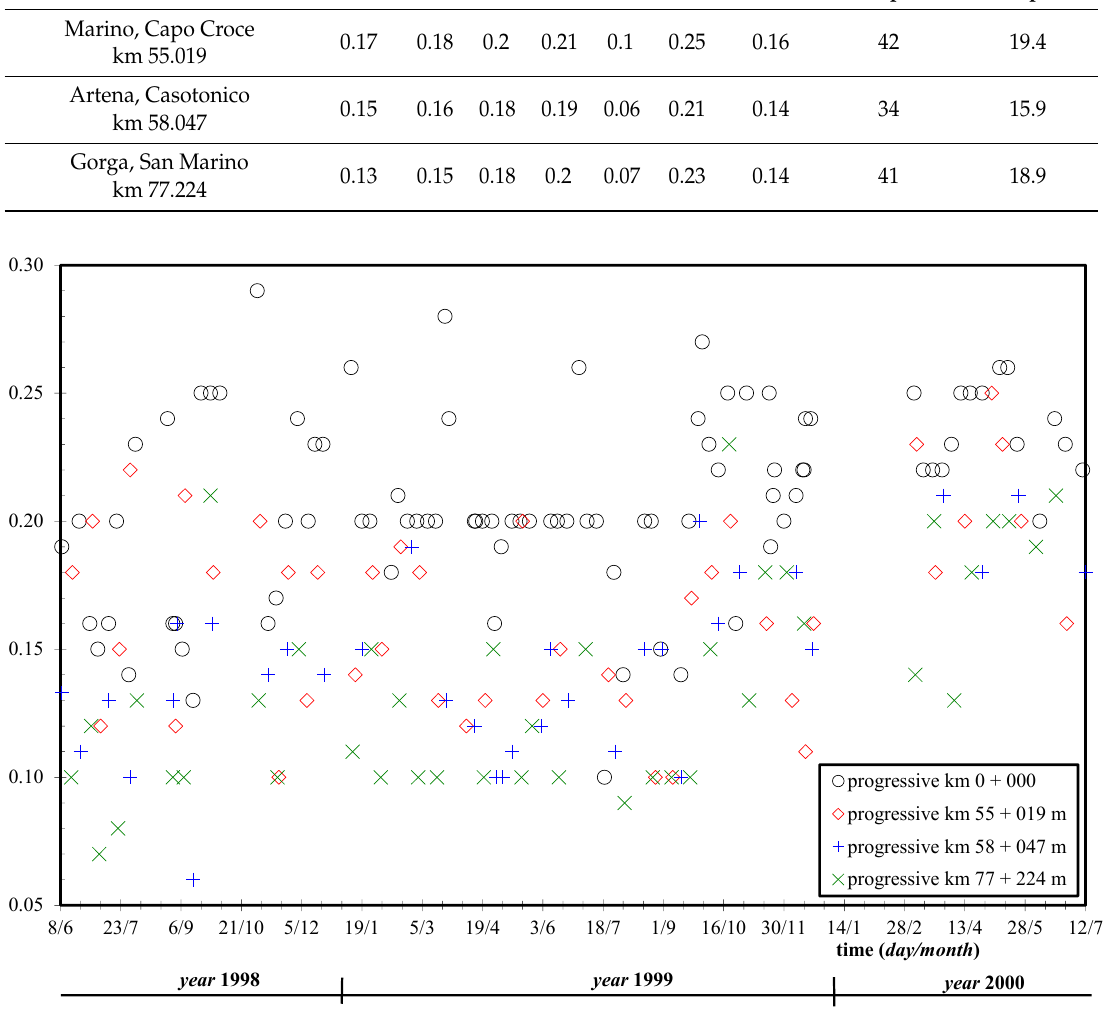
Figure 4. Trend of the chlorine concentration observed in sampling stations (up: progressive km 0, km 18.45, km 32.855; down: progressive km 0, km 55.019, km 58.047).